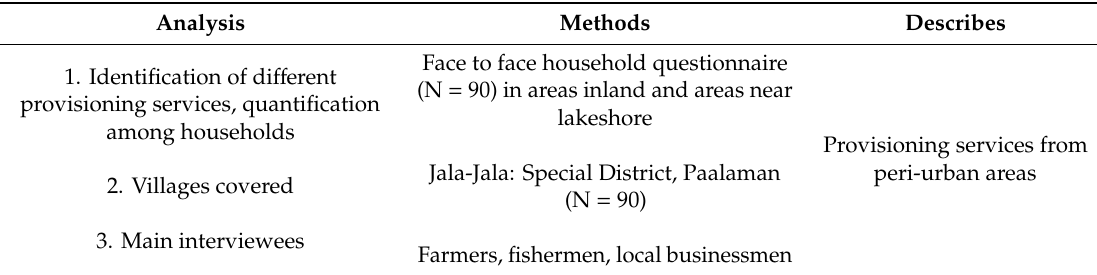
Table 1. Explanation of data for